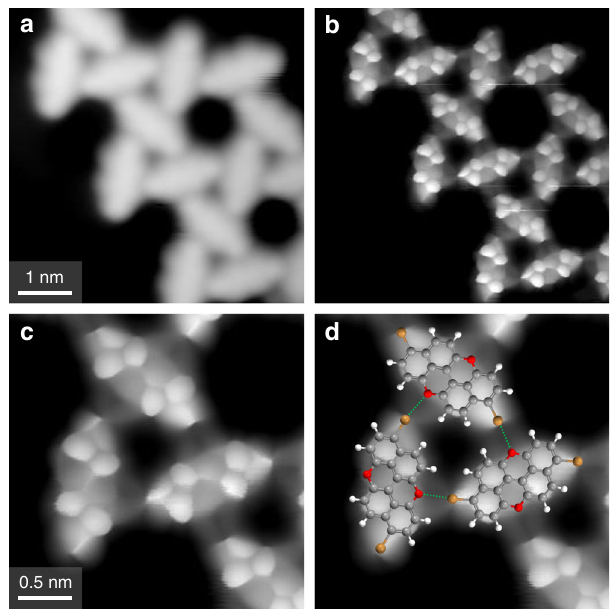
Fig. 4 High-resolution STM images of the 3,9-Br 2 PXX kagome assembly. a Constant current STM image recorded with typical scanning parameters with a CO tip ( V = 0.51 V, I = 160 pA). b Constant height HR-STM image of the same region as a ( V = 30 mV) with the CO tip close to the surface. c Smaller scale zoom of the same area seen in b, V = 30 mV. d Molecular model overlay of c , with halogen bonds indicated by green dotted lines. All images were recorded at 7